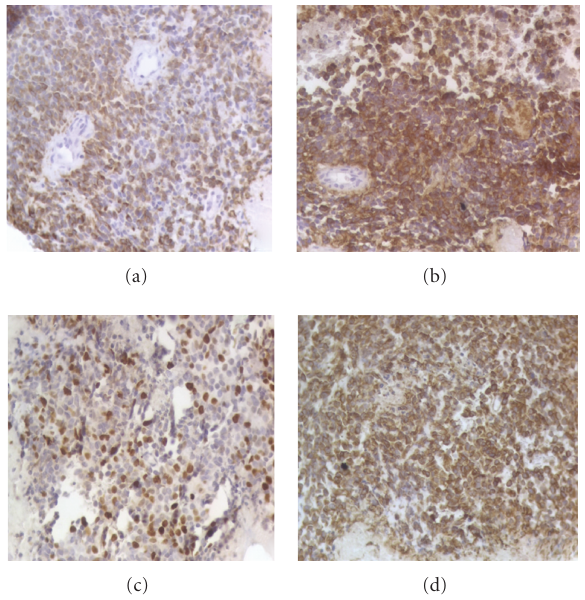
Figure 2: Positive immunohistochemistry for (a) desmin, (b) EMA, (c) Ki-67, (d) vimentin.